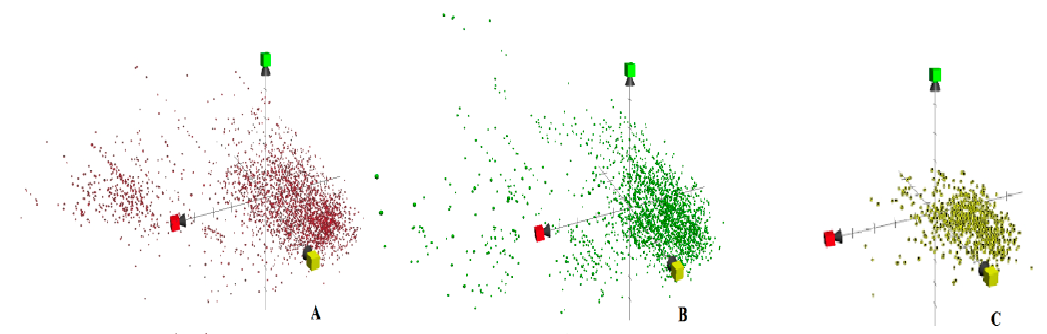
Figure 1. Different patterns revealed on plotting of ( A ) NIAID, ( B ) GVKBio, and ( C ) GSK on PC1 (x = red), PC2 (y = yellow) and PC3 (green) from ChemGPS-NP.